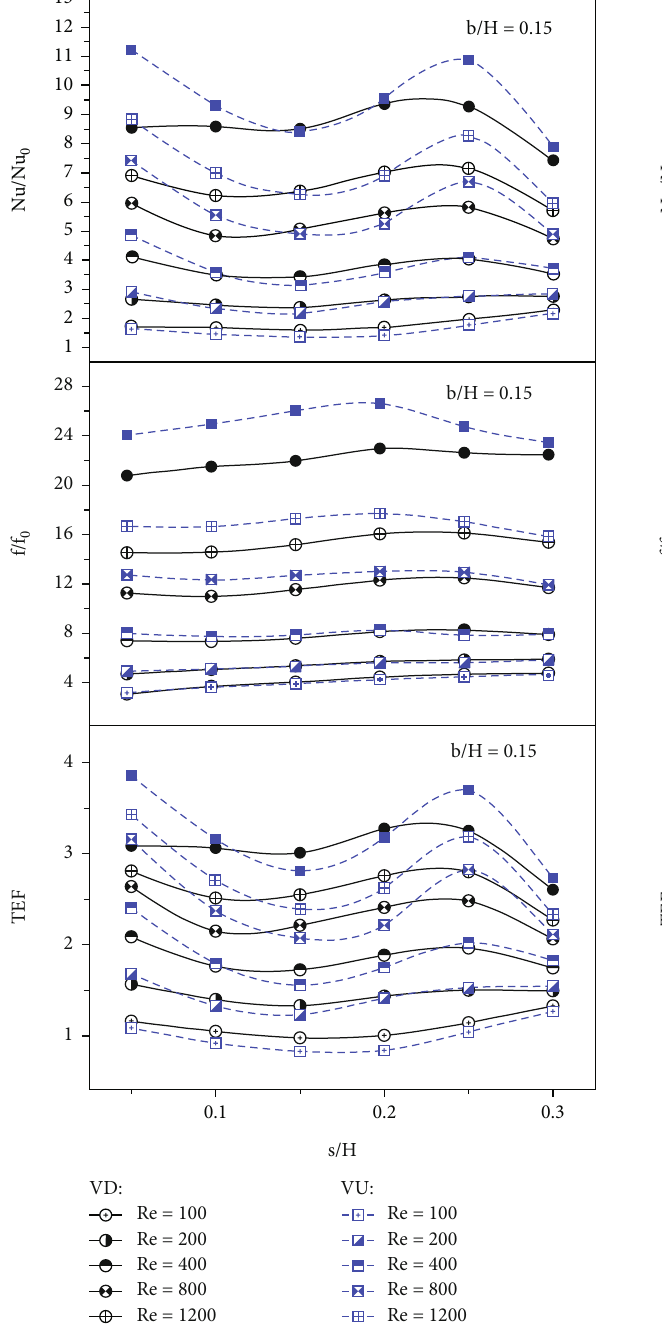
12: Thermal performance analysis of b / H = 0 : 20